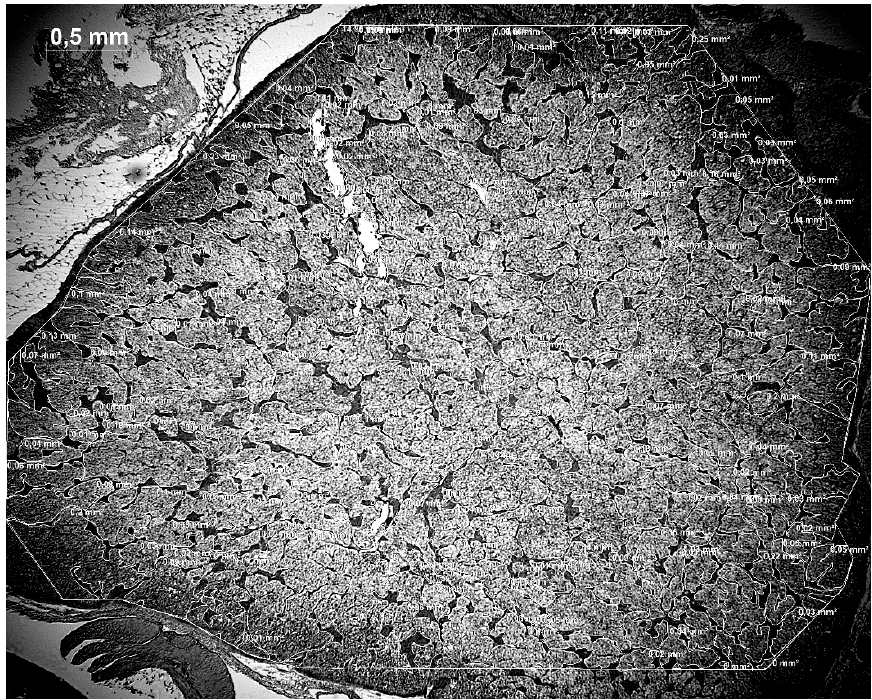
Figure 2. Adrenal gland with encircled and measured total area without artifacts, blood vessels and nonidentifiable tissues but with encircled and measured interrenal cells